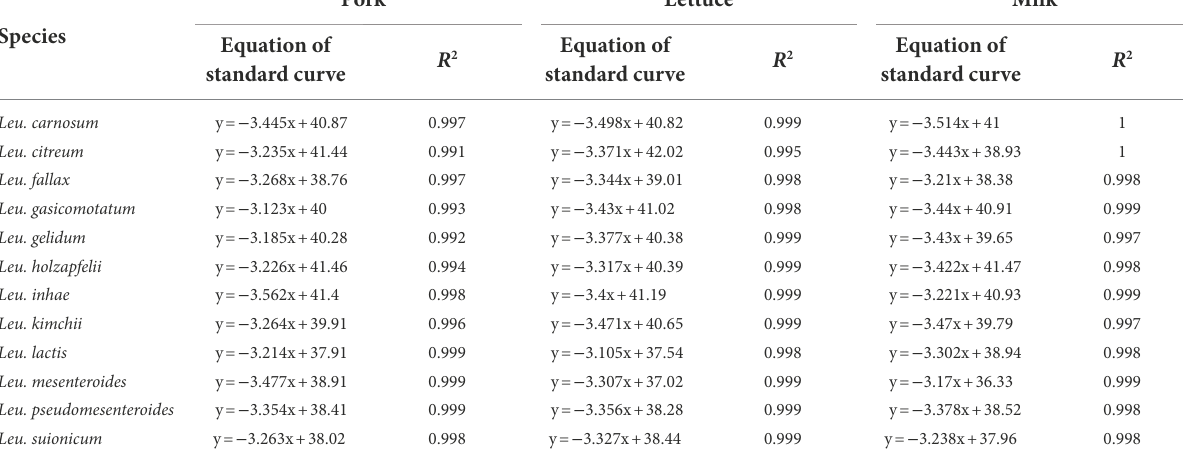
TABLE 3 The equation and coefficient of correlation values of standard curves in spiked pork, lettuce, and milk samples. Pork Species